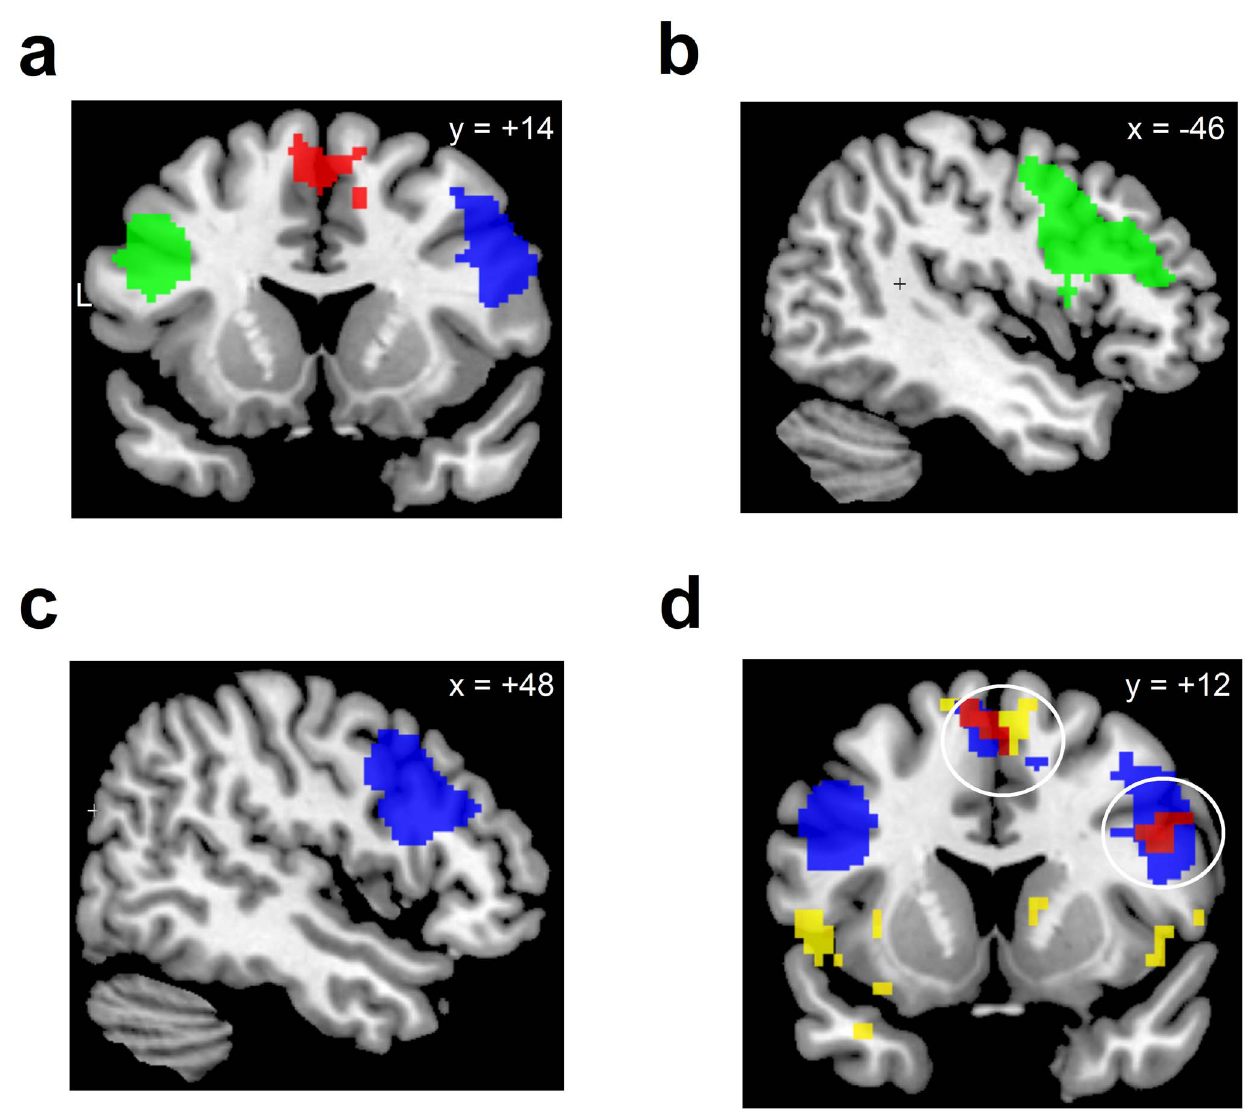
Figure 2. Regions of interest (ROI) used to identify effects of self-control exertion on prefrontal brain activity, superimposed on a coronal (a) or sagittal slice (b–c) of an anatomical template image. The three ROIs were functionally defined by the brain activation during the Stroop task (incongruent minus congruent trials; thresholded at p= .001, uncorrected, minimum cluster size k . 28) in an independent sample of 19 healthy women who watched only neutral pictures before performing on the Stroop task. Blue: right lateral prefrontal cortex (lateral PFC); green: left lateral PFC; red: medial frontal cortex (MFC). (d) Overlap of activation during suppression of emotions during picture-viewing (yellow) with regions of interests obtained during the Stroop task (blue). Overlap is mainly observed in the right lateral prefrontal cortex and in the medial prefrontal cortex (red). Regions of activation are displayed with a minimum cluster size of k . 28 at an individual voxel threshold of p =.001 in both analyses, superimposed on a coronal slice of an anatomical template image. (congruent vs. incongruent) was significant (mixed analysis of covariance [ANCOVA], F (1, 36) =7.99, p = .008, partial g 2 =.182; see Figure 1b). In addition, the analysis revealed the classic Stroop interference effect of more errors on incongruent than on congruent trials ( F (1, 36)= 4.23, p =.047, partial g 2 =.105). The main effect of group was also significant ( F (1, 36) =8.08, p =.007, partial g 2 = .183).